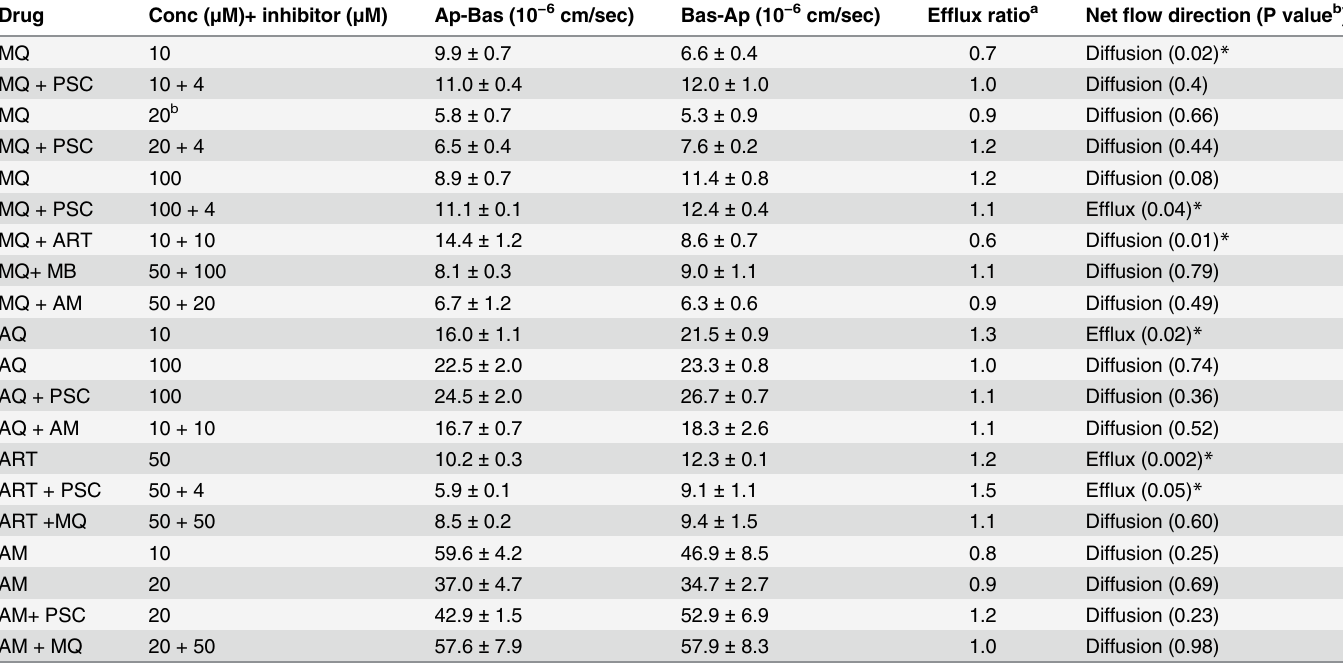
Table 2. Apparent permeability (P app ) and efflux ratio of antimalarials through Caco-2 cell monolayers.